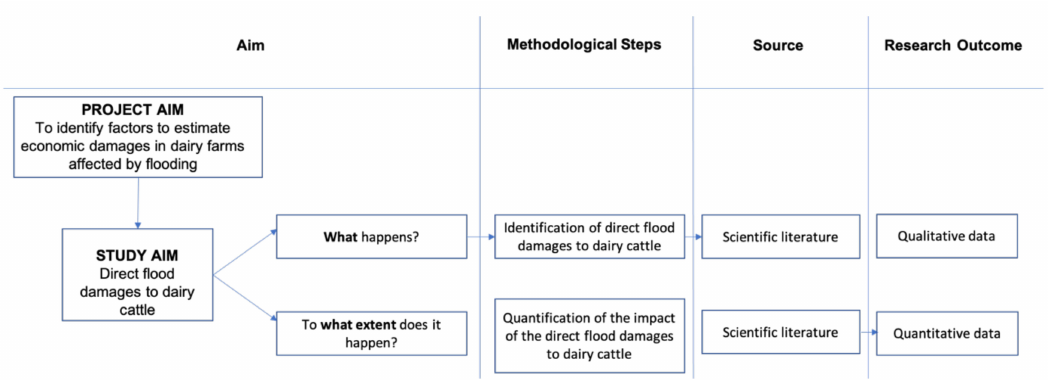
Figure 2. Purpose of the study and